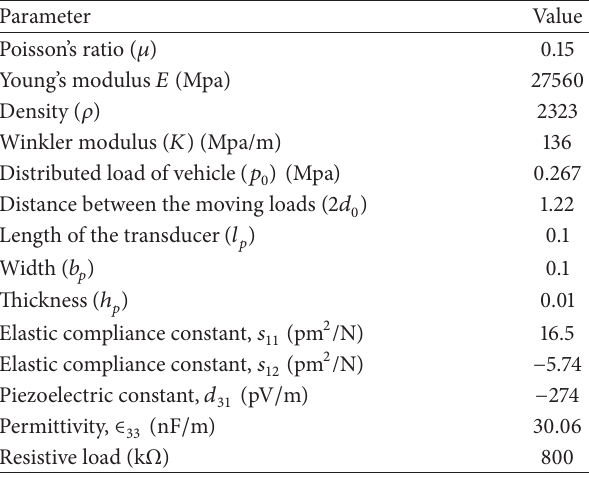
Table 5: Rectifier losses.